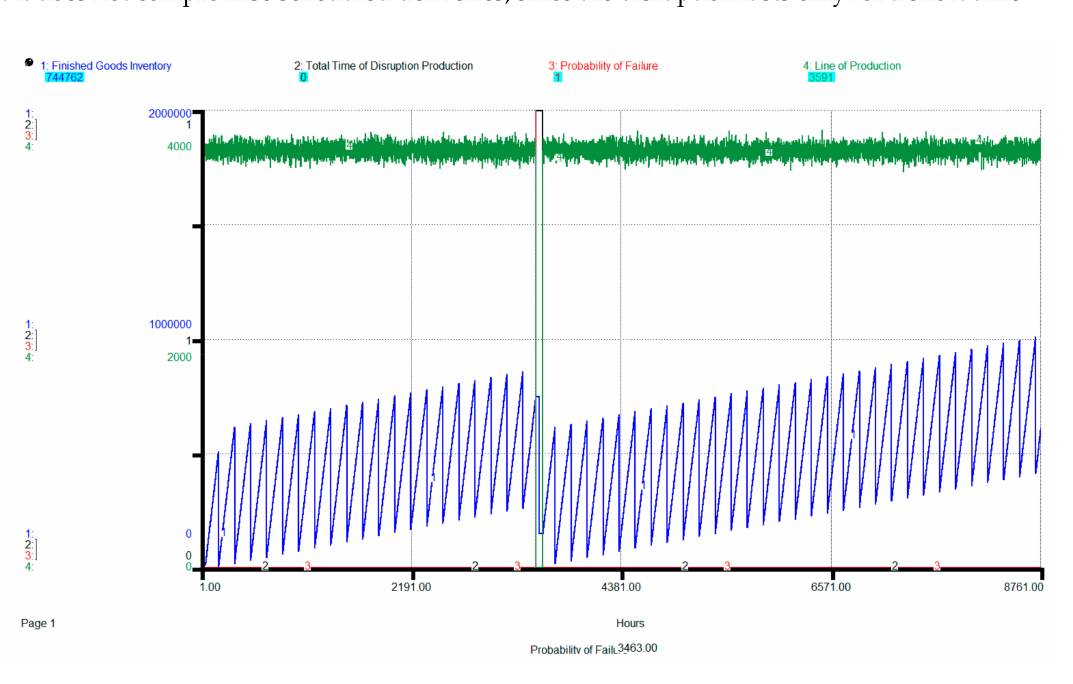
Figure 3. Time of disruption in production line with spare parts in